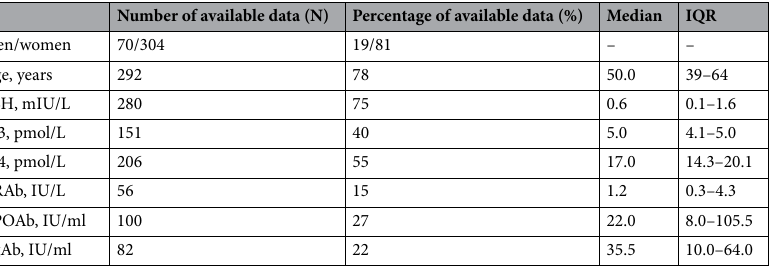
Table 1. Clinical data and laboratory test results of patients participating in the study. fT3 free triiodothyronine, fT4 free thyroxine, IQR interquartile range, N the number of valid answers, TgAb thyroglobulin antibodies, TPOAb anti-thyroperoxidase antibodies, TRAb TSH-receptor antibodies, TSH thyroid-stimulating hormone.